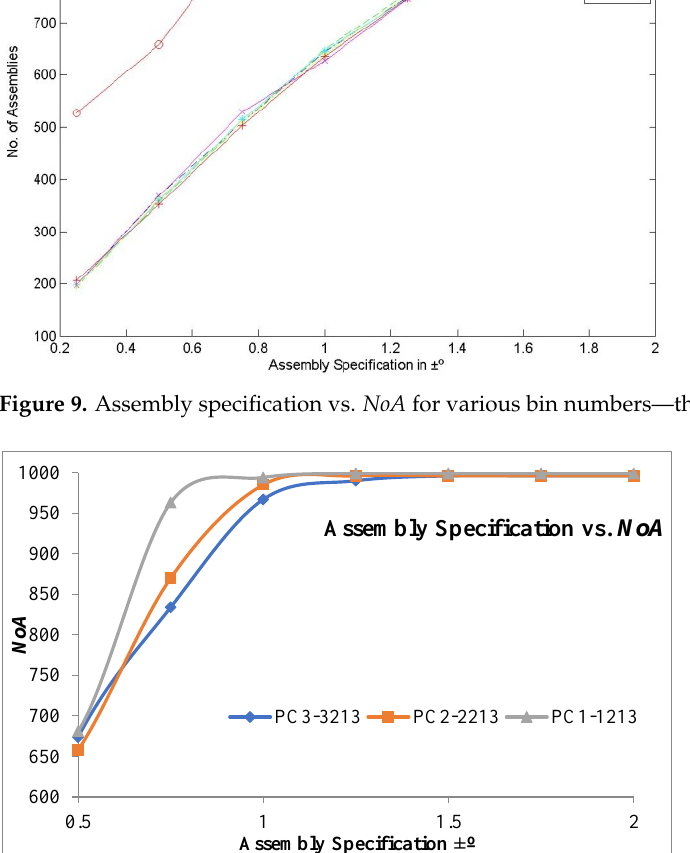
Figure 10. Maximum NoA produced for different assembly specifications and various process combinations. Table 15. Best bin combinations for various assembly specifications and process combinations. AS